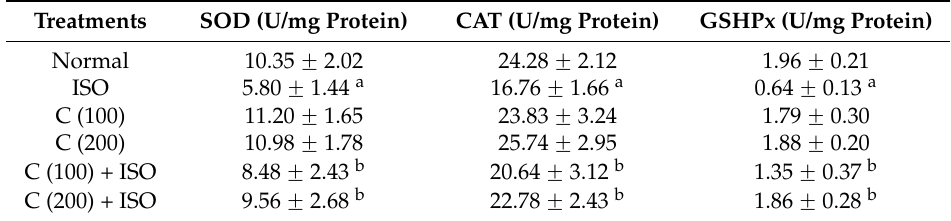
Table 4. Effect of cardamom on antioxidant enzymes in the isoproterenol-induced myocardial infarction in